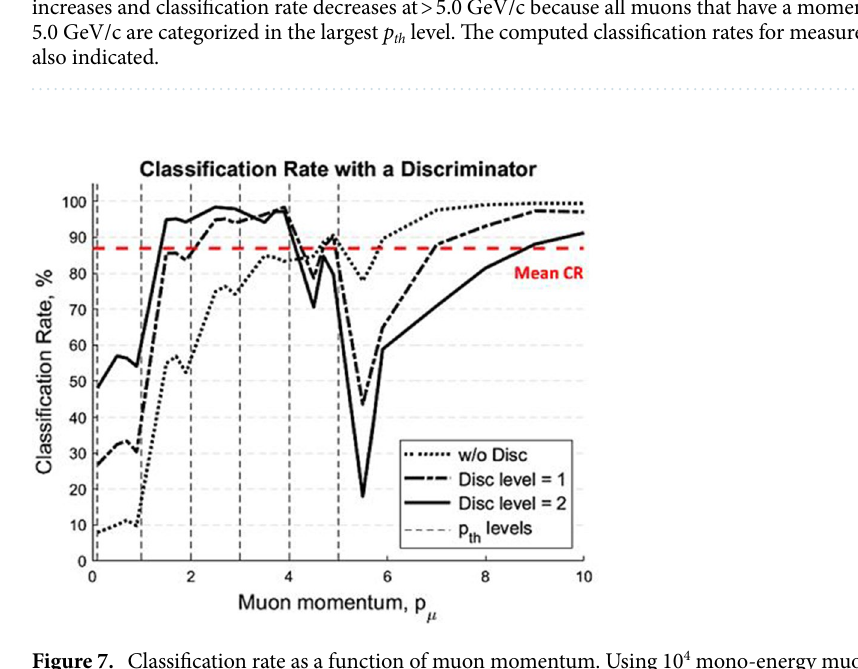
Figure 7. Classification rate as a function of muon momentum. Using 10 4 mono-energy muons, the classification rates are plotted as a function of muon momentum with various discriminator levels, 0, 1, and 2, from 0.1 to 10.0 GeV/c. Repeated sudden drops of CR are observed because muon momentum near p th boundaries tends to have a high false classification